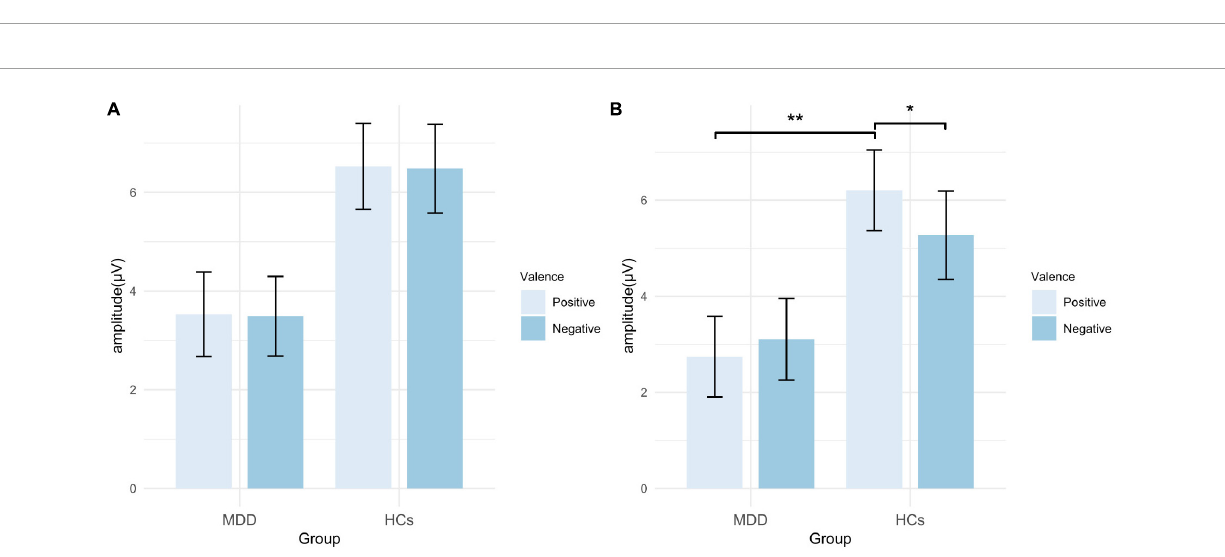
FIGURE6 Peak amplitude of P300 in EAST. (A) Amplitudes of self-words; (B) amplitudes of other-words. MDD, major depressive disorder; HCs, healthy controls; EAST, External Affect Simon Task; error bars represent the standard error. * p < 0.05; ** p <